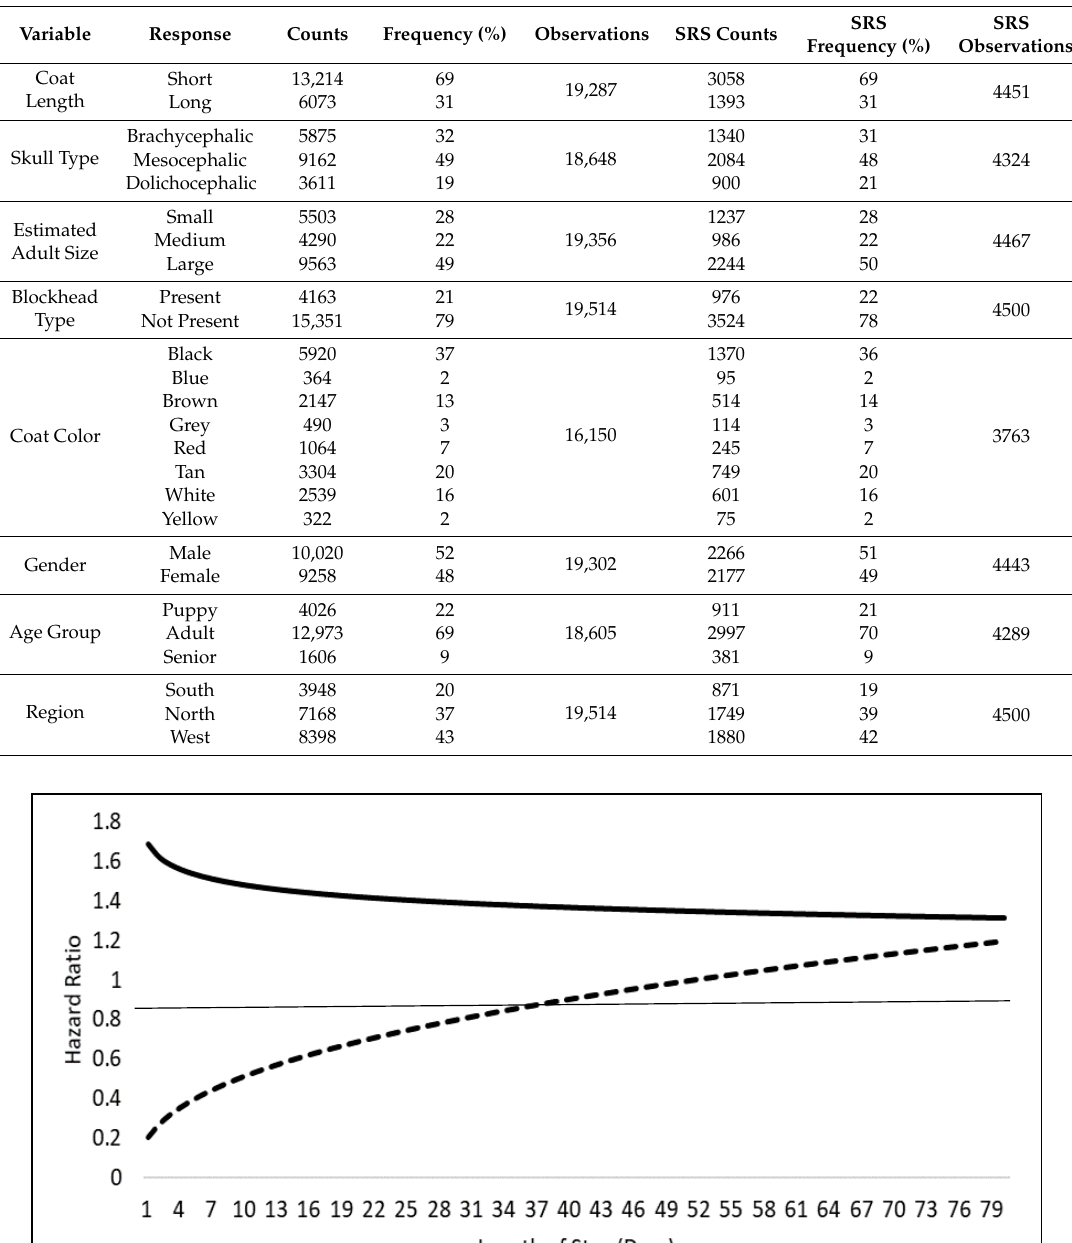
Table 1. Frequencies of phenotypes tested for multivariate adoption model inclusion using the full dataset 19,514 shelter dogs and the simple random sample (SRS) of 4500 dogs.